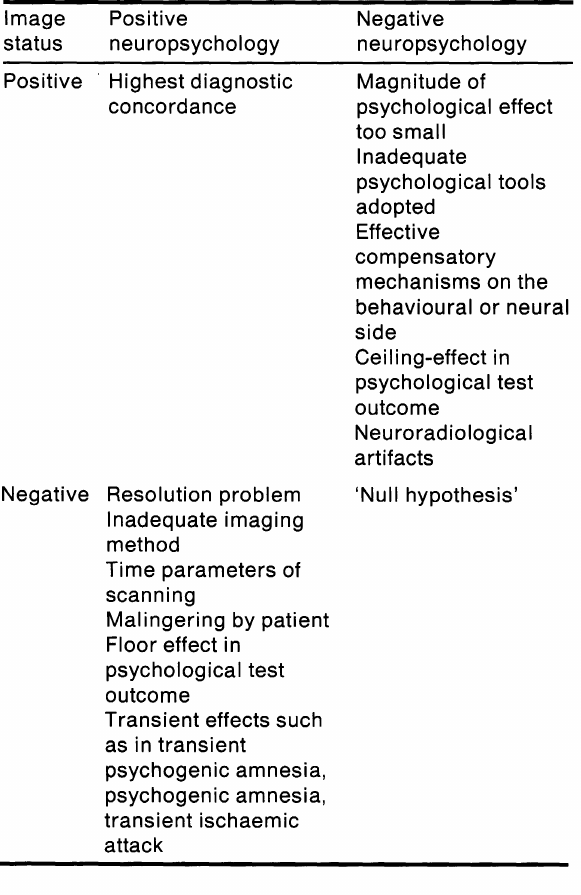
Table I. Possible relationships between neuropsychologi cal and neuroimaging outcomes